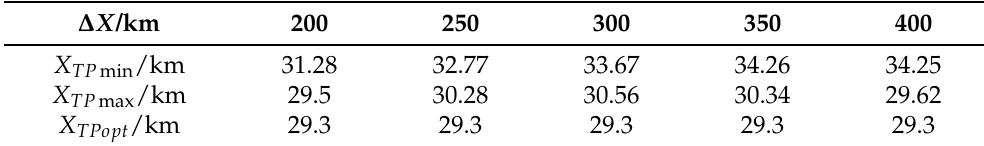
Table 2. Values of X TP